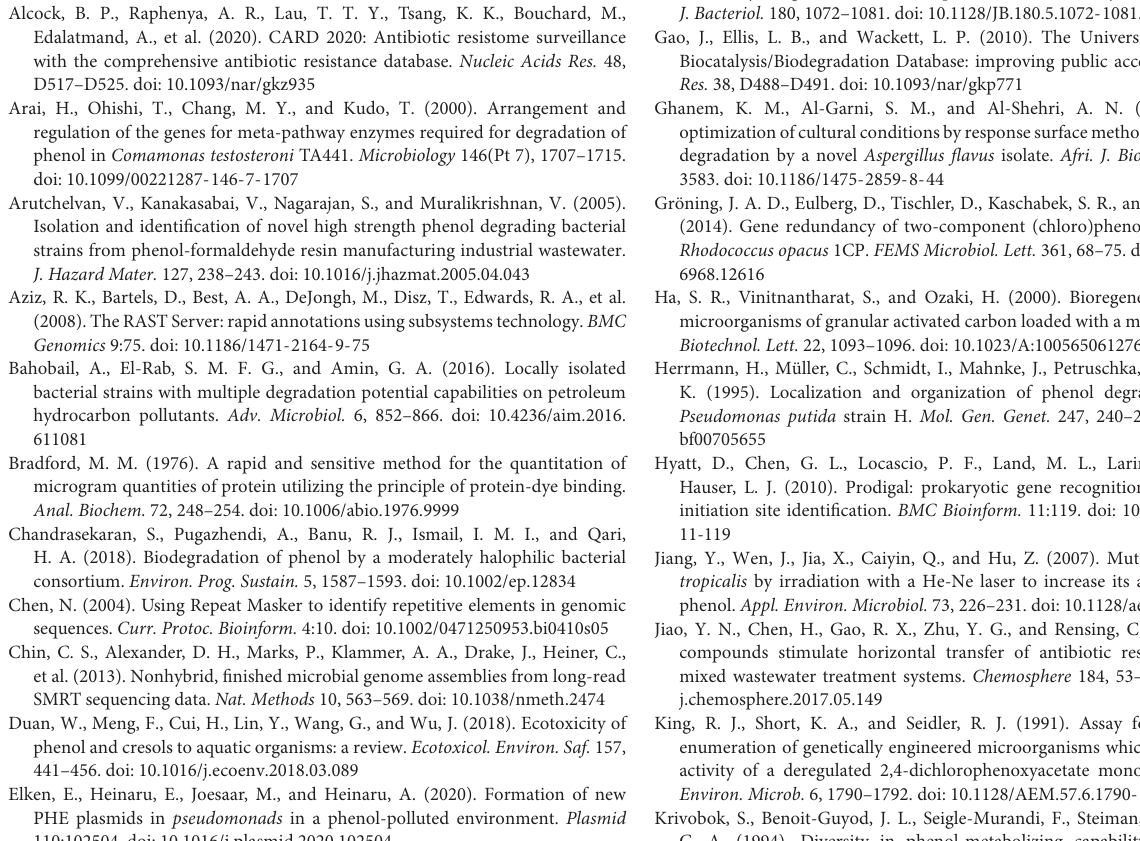
Supplementary Figure 1 | Morphological characteristics of A. lwoffii NL1 . Supplementary Figure 2 | Phylogenetic trees were constructed based on published 16S rRNA of Acinetobacter . Supplementary Figure 3 | Plasmid profile of the pNL1.